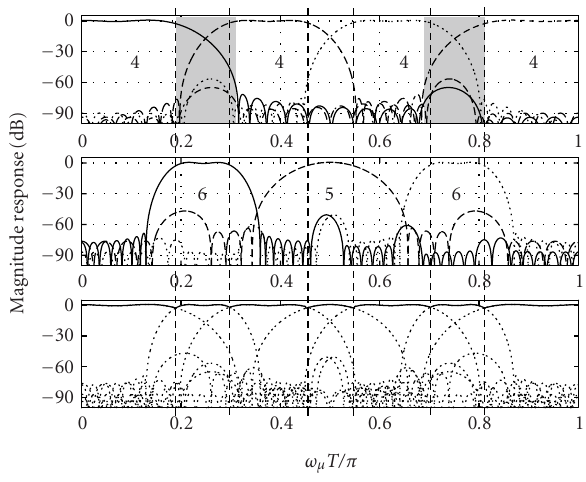
Figure 5: Top: frequency responses of the equidistant filters (with downsampling factor four in this example). Center: frequency re- sponses of the filters with other downsampling factors. Bottom: fre- quency response of the filter bank. The downsampling factors r are given within the corresponding passbands. The FIR filter orders are between M min = 34 and M max = 72 in this example. They realize a stopband attenuation of at least − 60 dB and allow passband ripples of ± 3 dB.